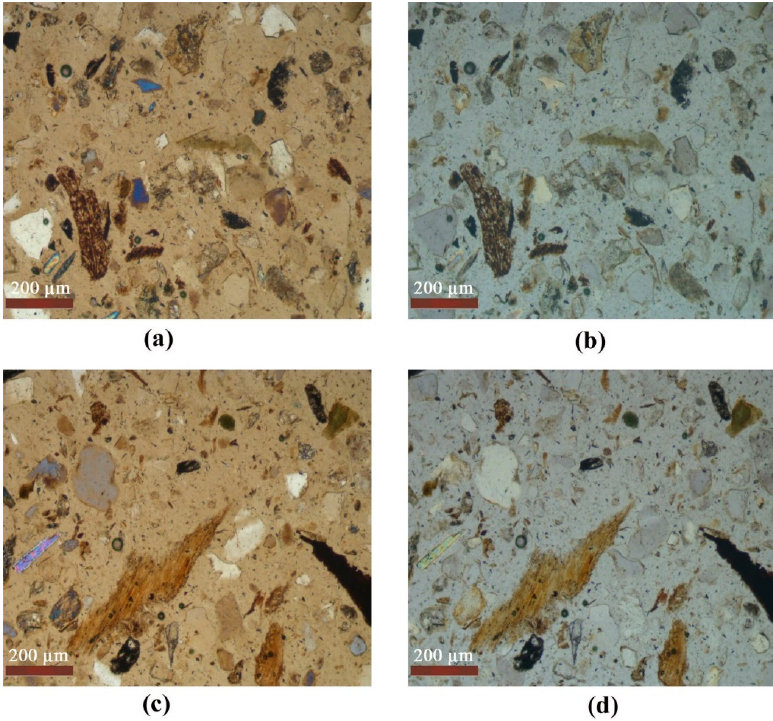
Figure 7. Poorly sorted mineral materials (S 1 − 7). ( a , c ) Plane polarized light; ( b , d ) crossed polarized light. In addition to intrusive redox pedofeatures in study soils, alteration of various micas (biotite/muscovite) occurs in Figure 8.